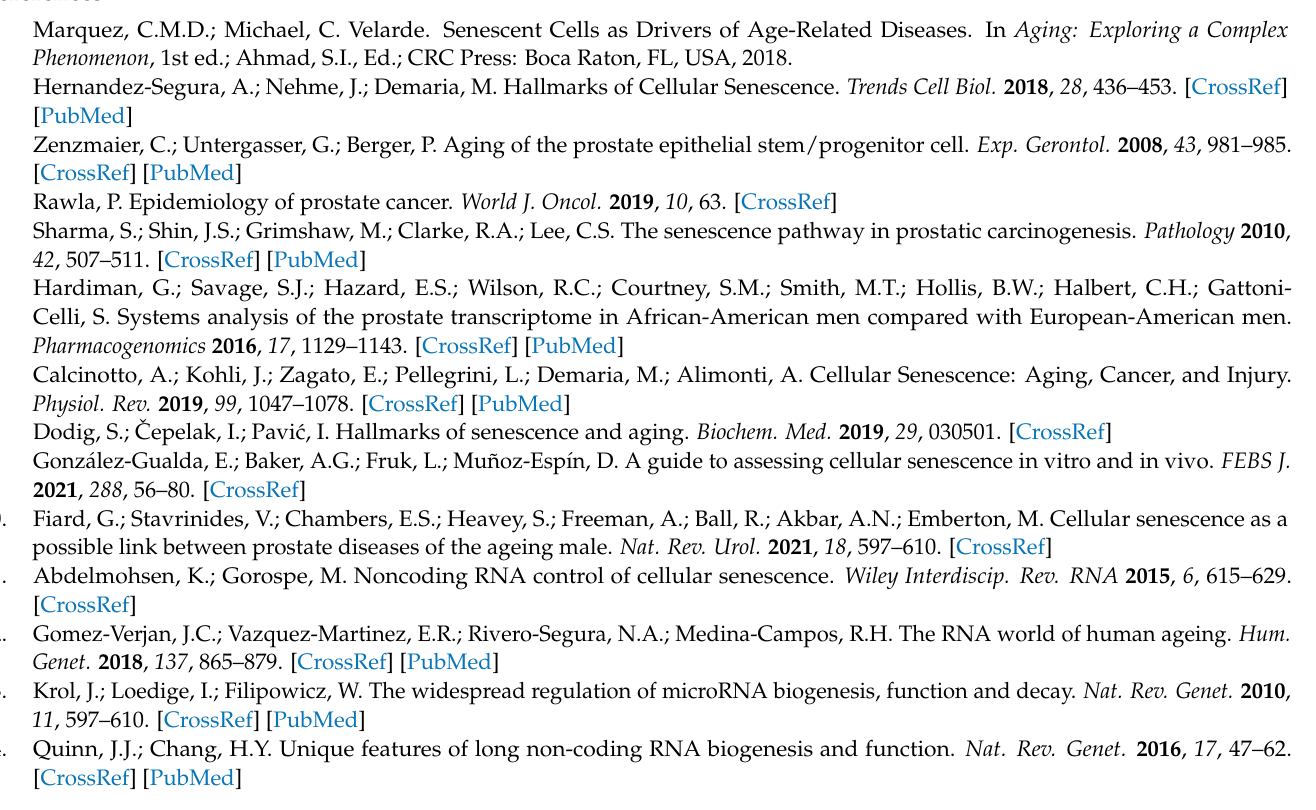
Table S3: miRNA DE analysis Results Prostate Cells. Table S4: Micro_RNA_impact. Table S5: DE lncRNAs. Table S6: lncRNA_impact. Table S7: Reg Network. Table S8: GO